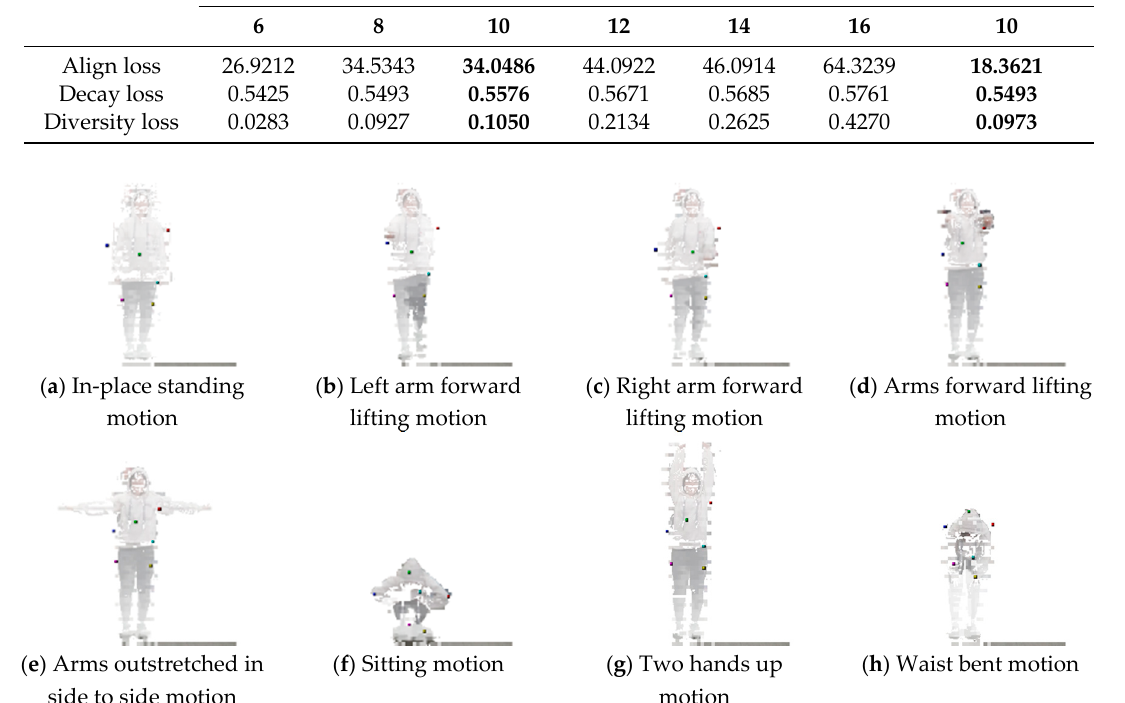
Table 1. Loss calculated using the encoder–decoder model. Table 2. Location of landmark extraction.